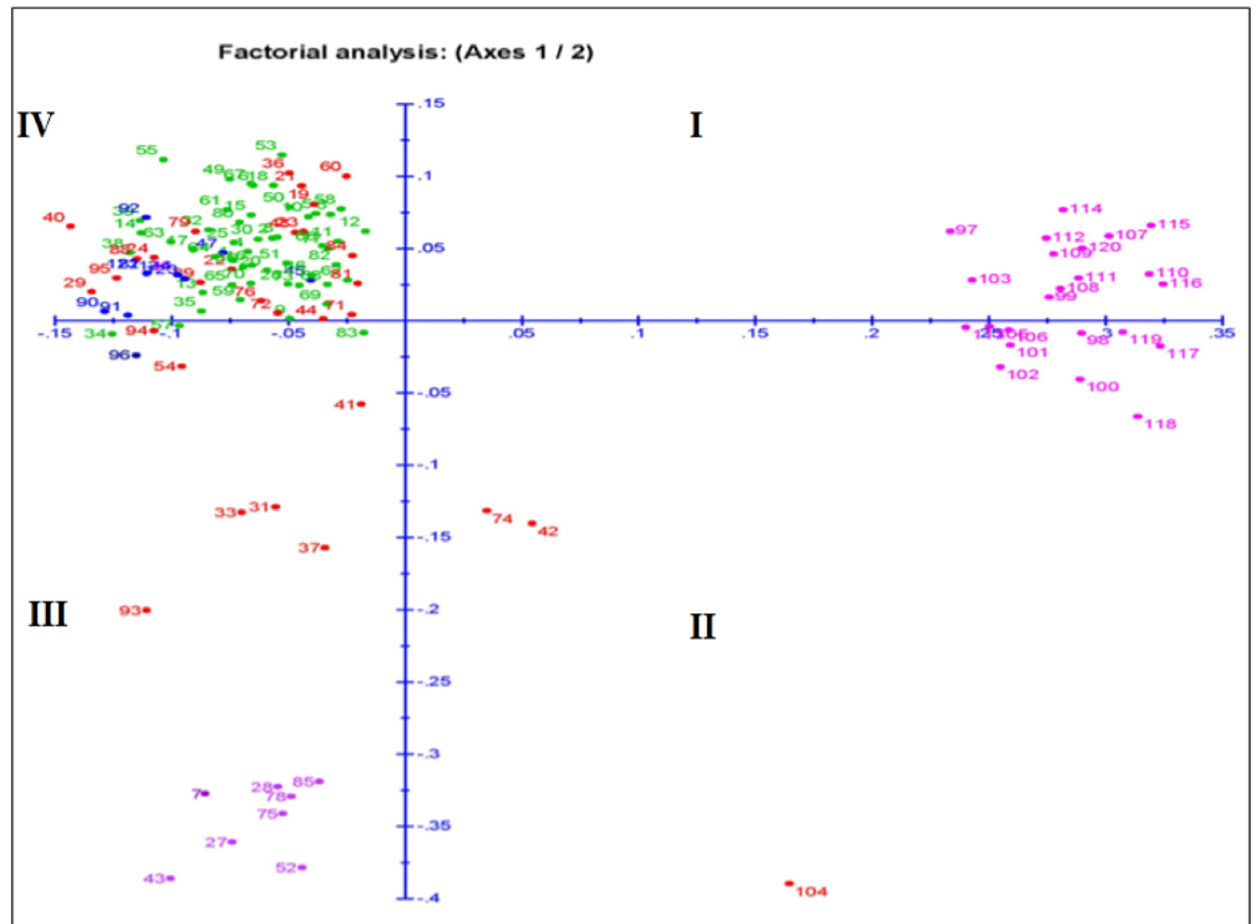
Figure 6. Plot for principal coordinate analysis of 124 genotypes present in the population for 4 growth parameters by genotyping with 143 microsatellite markers. The numbers in the dots indicate the serial of the landrace present in Table 1. The numbers are colored on the basis of sub-populations obtained from the structure analysis at K = 4 (SP1: blue; SP2: pink; SP3: green; SP4: violet; admix: red).